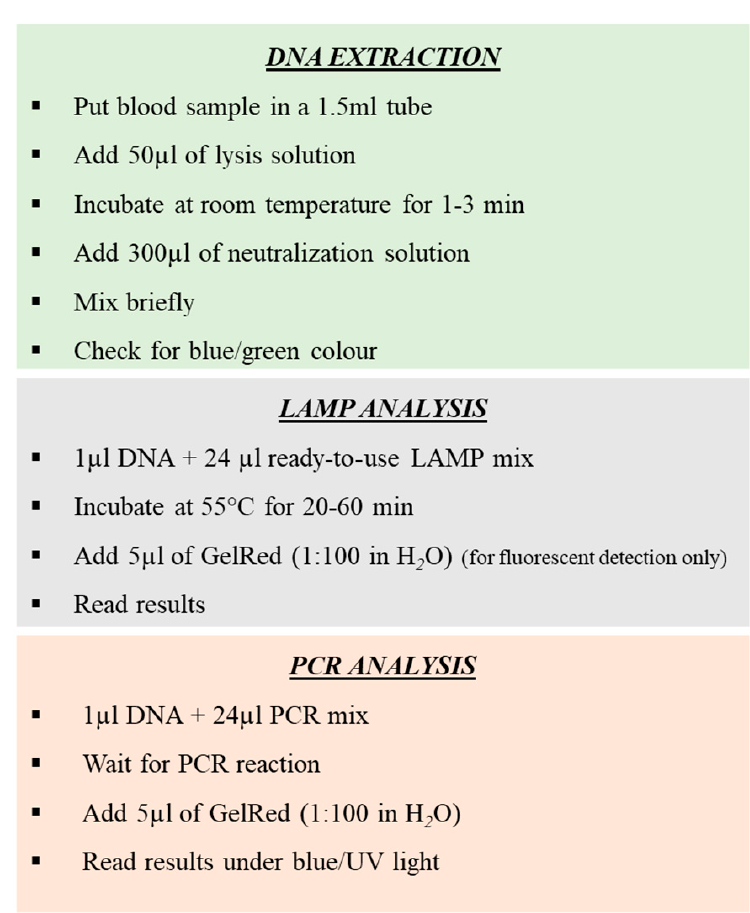
Figure 3. Step of amplification procedures for rapid sex determination of Procellariiformes , by loop- mediated isothermal amplification (LAMP) and high-performance PCR.